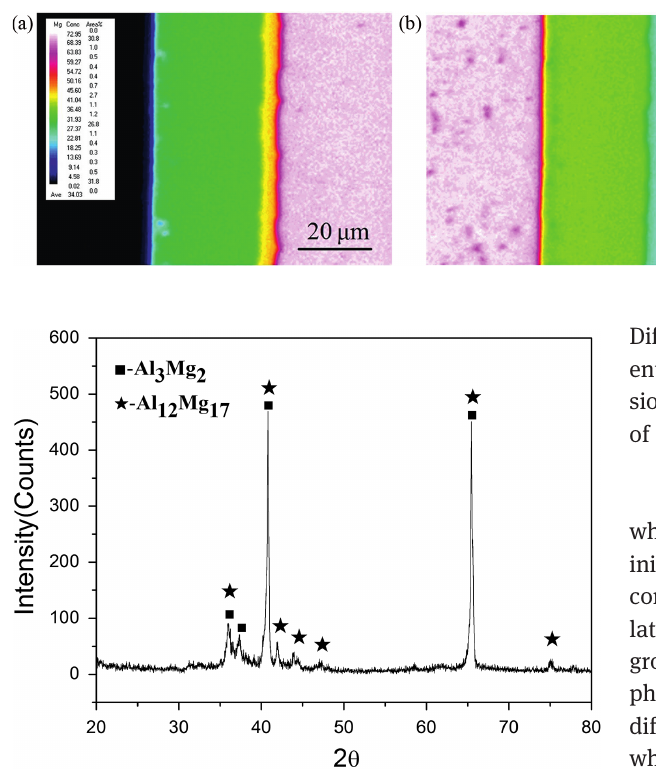
Figure 8: The elemental distributions at the bonded joint: (a) Mg; (b) Al.